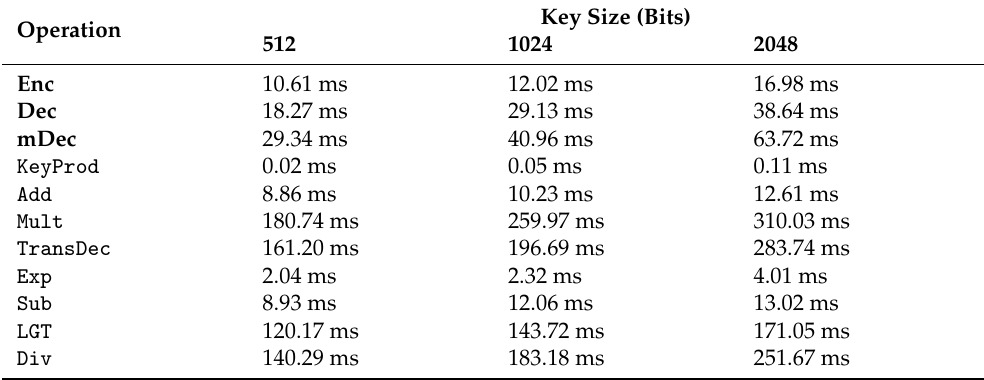
Table 1. Computation times of BCP algorithms and sub-protocols.